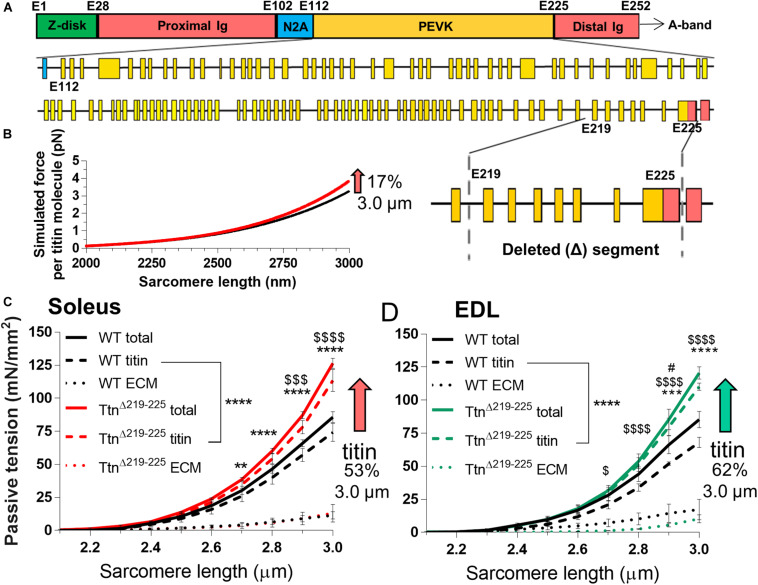
Passive tension in TtnΔ219–225 mice. (A) Schematic of titin’s I-band region, with exon composition of PEVK segment (below) and detailed facet of deleted segment (bottom-right), (Yellow: PEVK exons; red: Ig domains, blue: unique sequence). (B) Simulated titin tension for wildtype (WT; black line) and TtnΔ219–225 (red line), showing a minimal increase in passive tension (17% at SL 3.0 μm). The increase in passive tension was substantially higher in skinned soleus (C; 53%) and EDL (D; 62% at SL 3.0 μm). The increase in tension is due to changes in titin-based passive tension (curve fit p < 0.0001) and minor changes in extracellular matrix (ECM; n = 4 mice; t-test p-value: *total passive tension, $titin-based passive tension, #ECM-based tension; *p < 0.05, **p < 0.01, ***p < 0.001, ****p < 0.0001).